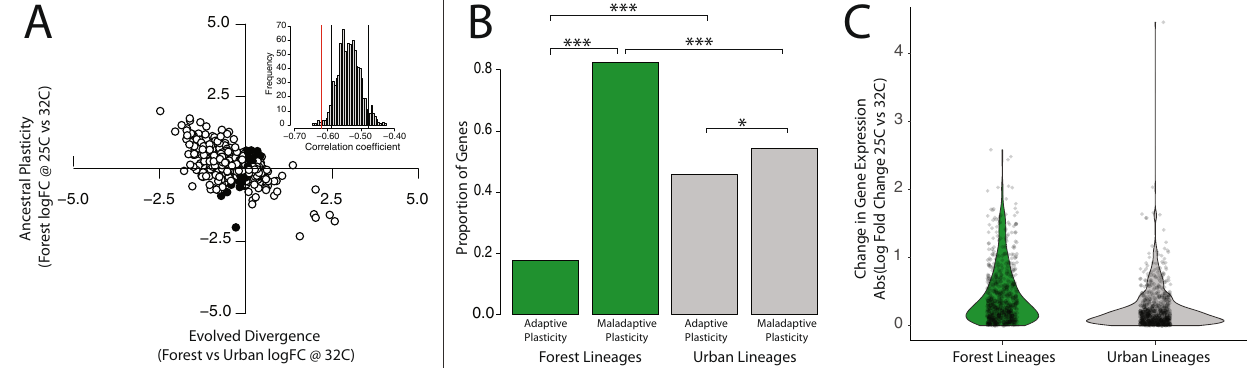
Fig. 6 Evolved gene expression divergence between urban and forest lineages measured through a common garden experiment. Lizards from urban and forest lineages from Mayagüez were born and raised in a common garden laboratory setting to study patterns of evolved divergence in gene expression between habitats types. A The relationship between ancestral (forest) plasticity of gene expression (25 °C vs. 32 °C) and evolved divergence in gene expression under heat challenge (forest vs urban at 32 °C). Each dot represents a single gene from the focal set of CT MAX -associated genes ( n = 632). Dots displayed in black represent genes with a positive correlation between ancestral plasticity and evolved divergence. Those displayed in white represent genes with a negative association between ancestral plasticity and evolved divergence (Spearman ’ s ρ = − 0.61). Among genes associated with heat tolerance, evolved divergence reverses the direction of ancestral plasticity. Inset: the observed correlation coef fi cient (red line) is more negative than the lower 95th percentile of a randomized null distribution (black line). B Bar graph representing the number of genes displaying adaptive vs. maladaptive plasticity in common garden lineages from forest (green) and urban (gray) habitats. Figure 5 outlines the methodology of plasticity categorization. Among genes associated with heat tolerance, urban lineages possess a signi fi cantly larger proportion displaying adaptive plasticity and a signi fi cantly lower proportion that displaying a maladaptive plasticity in response to increased temperature. Asterisks represent degree of signi fi cance (equality of proportions test within habitat types, exact binomial test between habitat types: * p < 0.05, *** p < 0.001). C Violin plot displaying heat-induced regulatory plasticity (log- fold change in expression from 25 °C to 32 °C) in forest (green) and urban (gray) lineages. Individual genes are represented by gray dots. Urban lineages display an overall lower magnitude of gene expression plasticity (Welch two-sample t -test: p < 0.001), congruent with evolutionary attenuation of maladaptive plasticity. Sixteen animals from common garden conditions were used for these analyses (25 °C; forest n = 4, urban n = 5) or average urban (32 °C, forest n = 3, urban n =